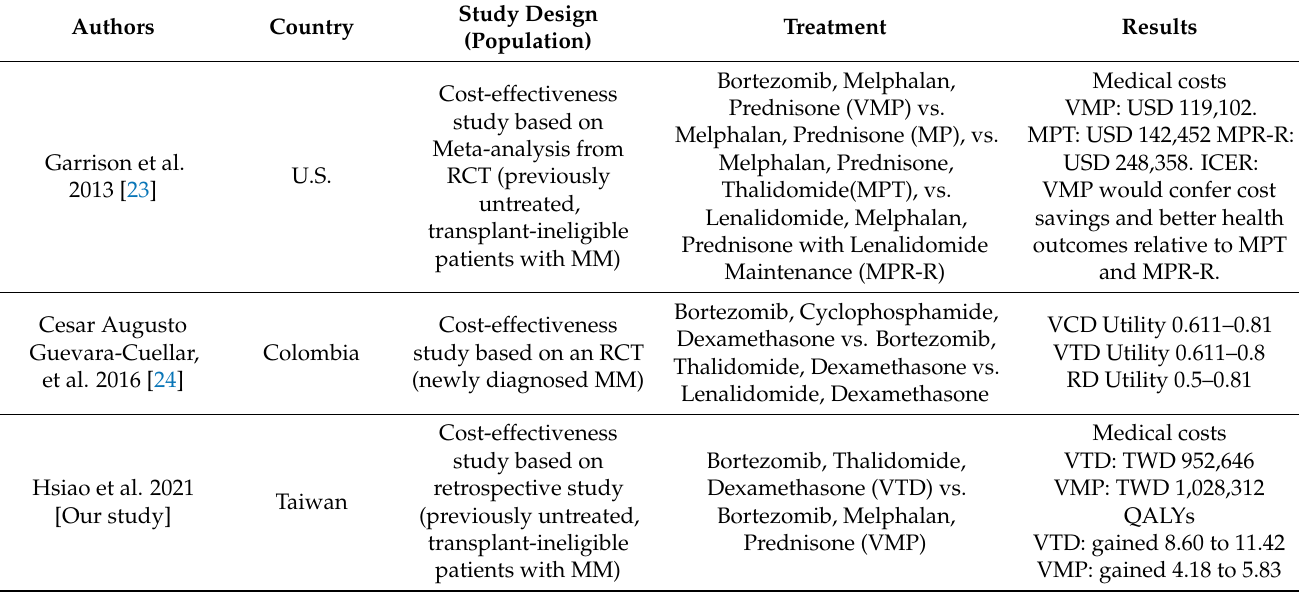
Table 4. Summary of utility values for the treatment of multiple myeloma